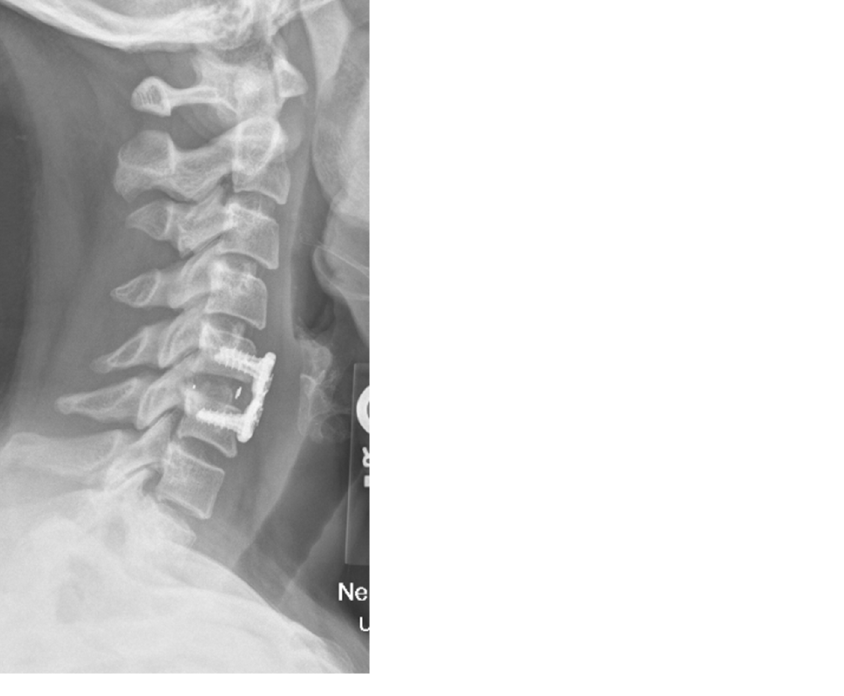
Figure 3. Cervical spine X-ray demonstrating polyether ether ketone (PEEK) interbody after a C5–C6 anterior cervical discectomy and fusion.